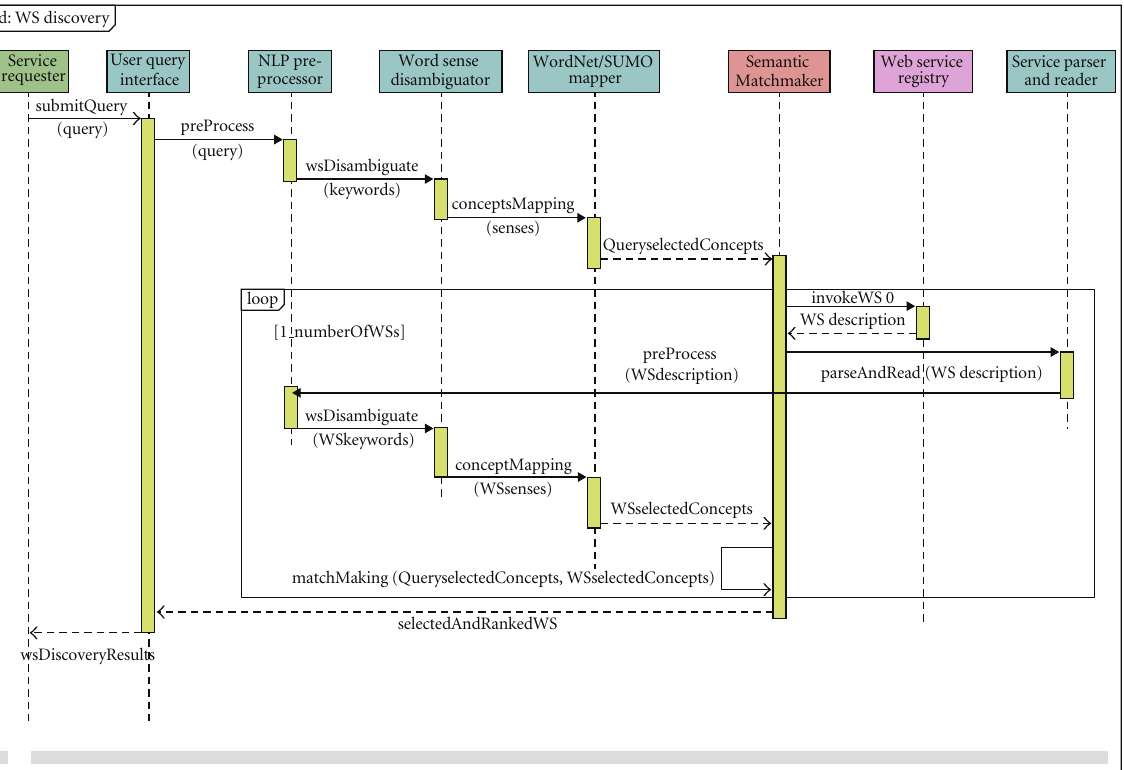
Figure 2: Sequence diagram for use case “discovery of Web